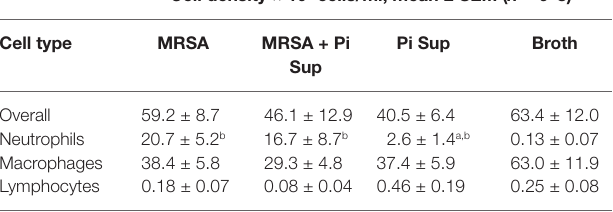
TABLE 3 | Inflammatory cell density of bronchoalveolar lavage fluid from mice infected with MRSA with or without Pi